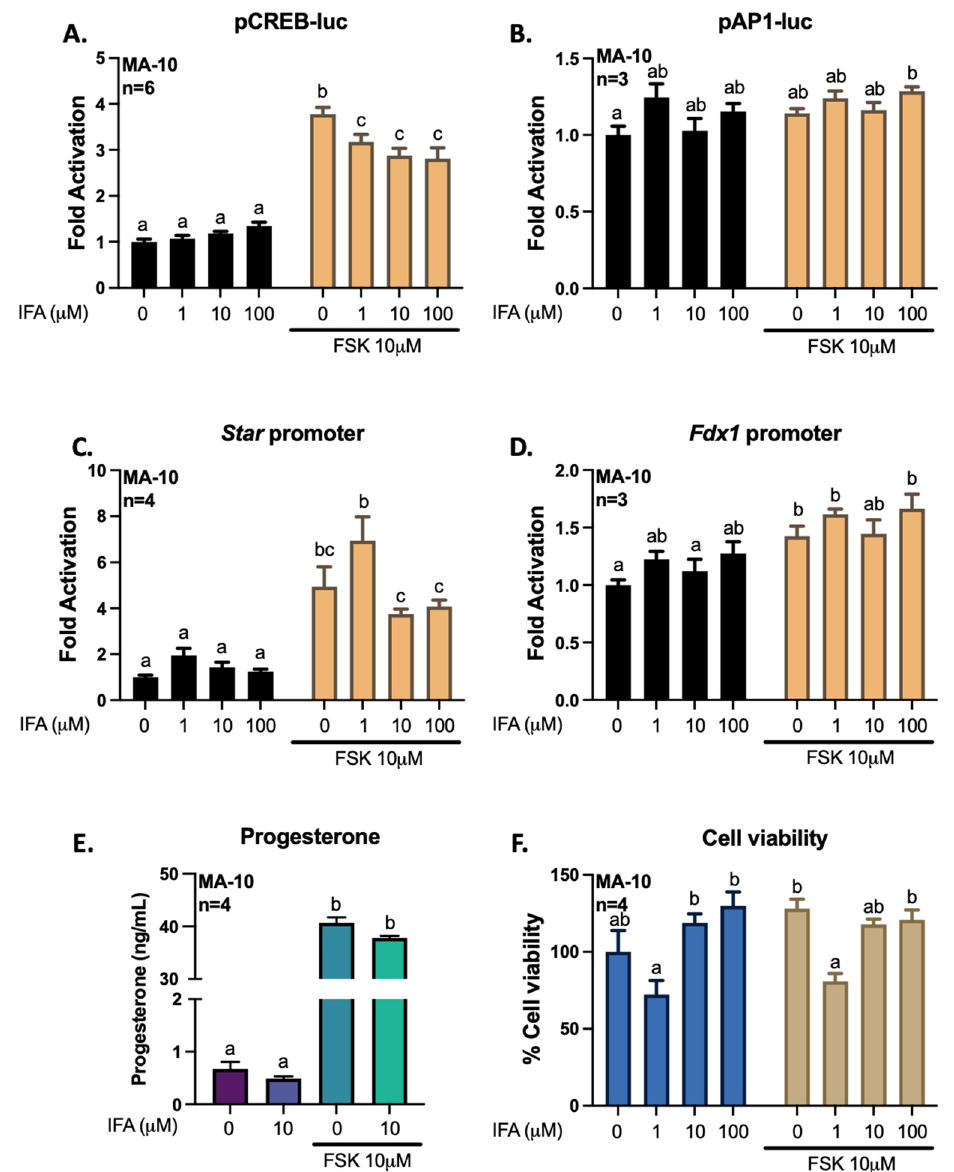
Figure 11. Effects of increasing levels of isoferulic acid (IFA) on the activities of pCREB-luc ( A ), pAP1-luc ( B ), Star promoter ( C ), or Fdx1 promoter ( D ). MA-10 Leydig cells were transfected with a luciferase plasmid reporter harboring 4 consensus CREB regulatory elements, 3 consensus AP1 regulatory elements, the − 902 to +17 bp mouse Star promoter, or the − 1003 to +45 bp Fdx1 promoter, upstream of the gene for Firefly luciferase. Cells were treated for 4 h with increasing doses of isoferulic acid (1, 10, or 100 μ M) with or without the adenylate cyclase activator forskolin (FSK) at 10 μ M. Results are shown as Fold Activation over control (DMSO only) ( ± SEM). Progesterone was quantified by ELISA from the cell culture medium ( E ), and cell viability ( F ) was determined using the Crystal Violet method. A two-way ANOVA was used to analyze data according to concentrations of isoferulic acid and stimulation with FSK, followed by Holm Sidak’s multiple comparison test. A different letter denotes a significant difference ( p < 0.05).